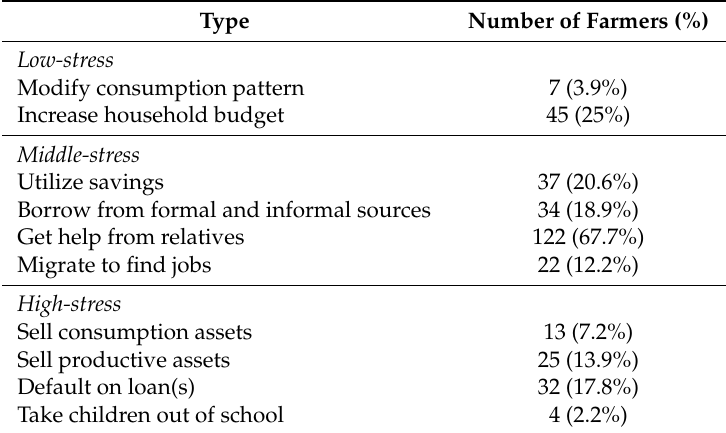
Table 5. Type of ex post coping strategies adopted by farmers.